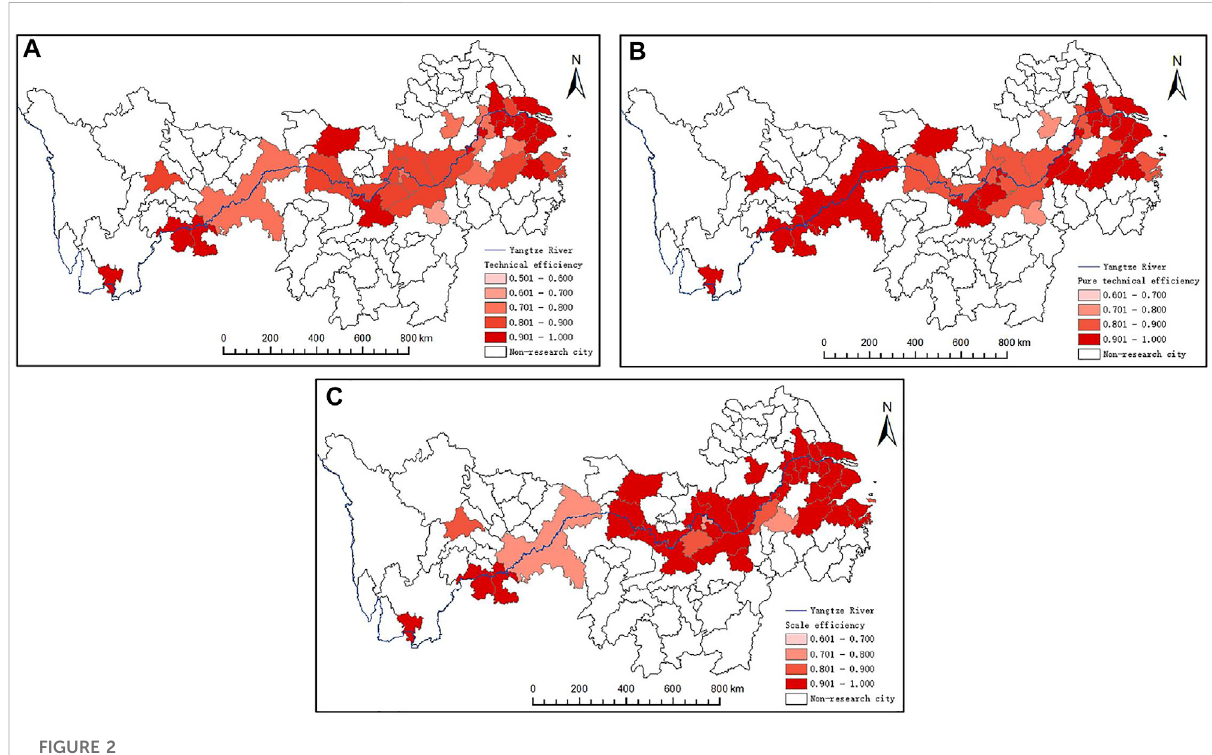
FIGURE 2 Five-year average TE, PTE, and SE. (A) TE; (B) PTE; (C) SE.